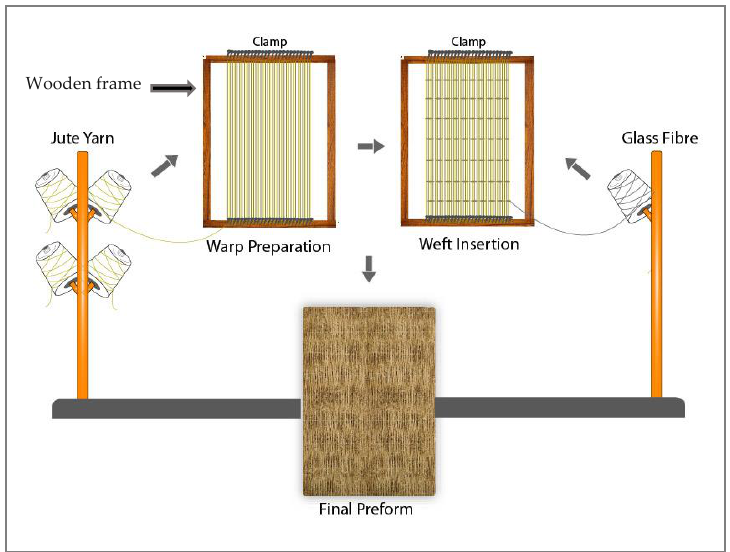
Figure 1. Illustration of the unique preform preparation technique used in this study. Table 2. The physical properties of the developed preforms and the yarns used in this study.